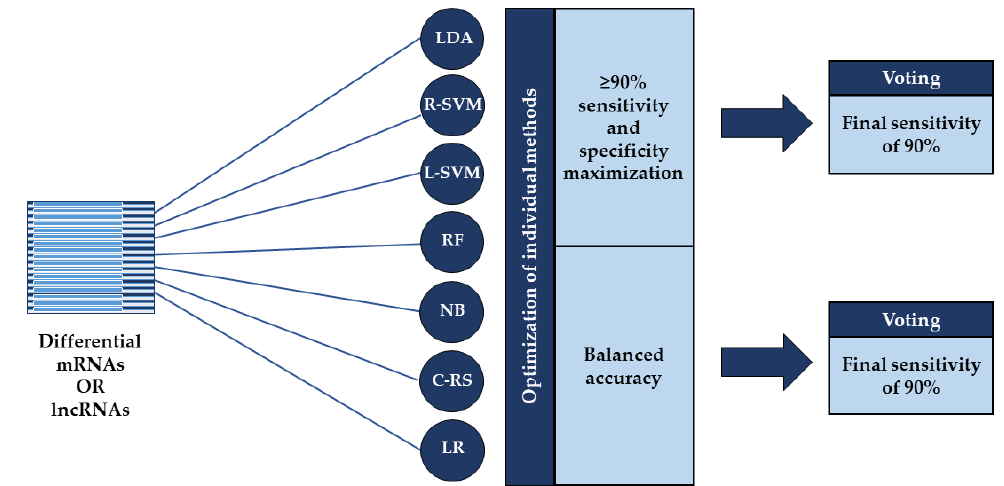
Figure 1. Overview of the two applied classification strategies. Classification was performed according to the differentially expressed mRNAs or lncRNAs using seven machine learning methods: linear discriminant analysis (LDA), support vector machines based on a radial kernel (R-SVM) or linear kernel (L-SVM), random forest (RF), naïve Bayes (NB), COX risk score (C-RS), and logistic regression (LR). The individual methods were optimized using two different approaches: one that provided ≥ 90% sensitivity while maximizing specificity and one that optimized balanced accuracy where both were followed by voting with a final sensitivity of 90%.